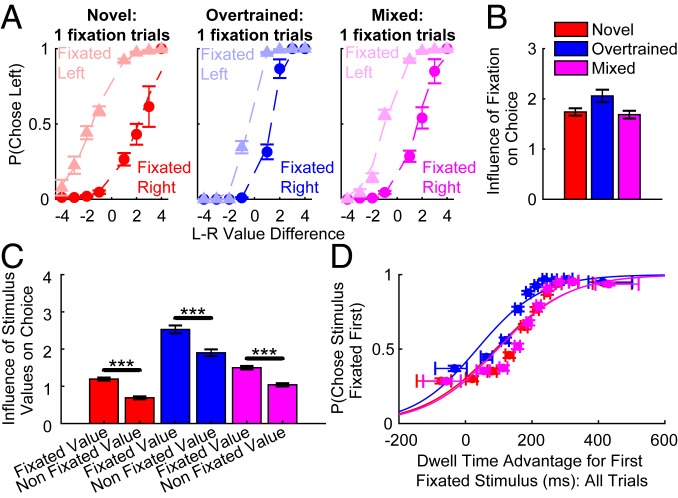
Influence of fixations on economic choice. (A) The influence of the direction fixated, over and above value difference, on trials where a single stimulus was fixated. A separate plot shows novel, overtrained, and mixed trials. Markers show the proportion (±SE) of left choices at a specific value difference. The lightly shaded data are for trials where subjects looked left, and the darker data for where subjects looked right. Subjects were more likely to choose the option they fixated. Dashed lines represent a logistic model fit (SI Appendix, Text). (B) Logistic regression coefficients (±SE) for a model predicting economic choice. The direction fixated significantly influenced choice over and above stimulus value. (C) The influence of fixated and nonfixated stimulus values on choices in 1-fixation trials. Logistic regression coefficients (±SE) show that both stimuli significantly influenced choices but the fixated value had a stronger influence (SI Appendix, Text). ***P < 10−10. (D) The probability of choosing the item fixated first, as a function of the final dwell time advantage allocated to that stimulus (SI Appendix, Text). The dwell times are binned into 10 deciles, with the mean choice probability (±SE) for each bin indicated with a circular marker at the median dwell time of the bin. Lines show a logistic fit of the data. Horizontal error bars show the interquartile range (i.e., central 50% values) for dwell times. This analysis includes all trials for each condition type (i.e., novel, overtrained, or mixed). Subjects were more likely to choose the first fixated item when there was a greater time advantage in fixation duration allocated to it.